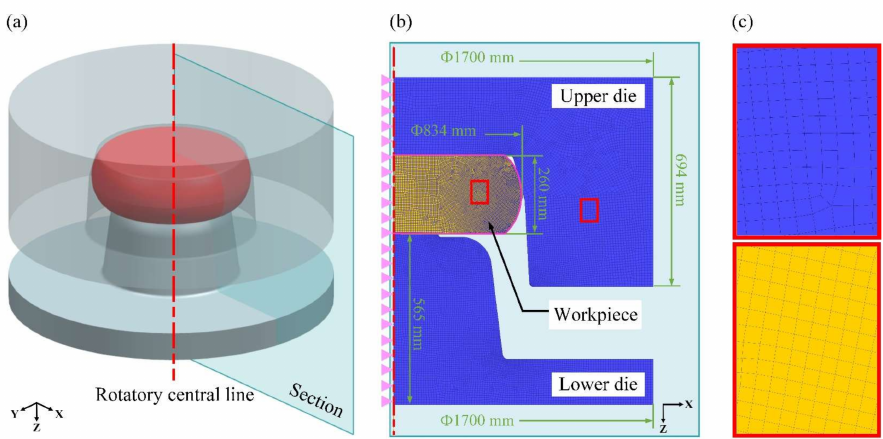
Figure 1. ( a ) Drum structure, ( b ) 2D simplified FE model, and ( c ) the mesh details of dies and